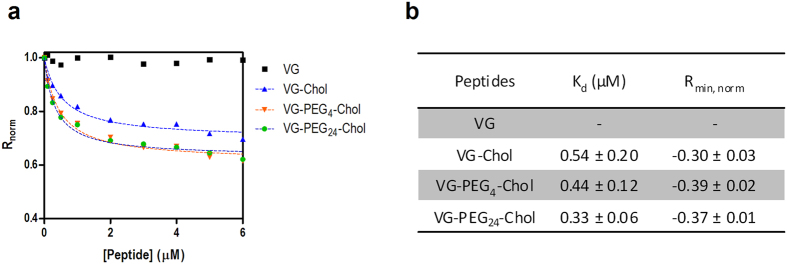
Peptide affinity towards RBCs assessed by di-8-ANEPPS fluorescence.(a) The dependence of the ratio R on VG (black), VG-Chol (blue), VG-PEG4-Chol (orange) and VGPEG24-Chol (green) concentrations for RBCs was analyzed by a single binding site model (dashed lines) in order to quantify the apparent dissociation constants, Kd. The R values were normalized for the initial value of zero peptide concentration. (b) The Kd values represent the mean ± s.e.m. (n = 4). Rmin is the asymptotic minimum value of R.